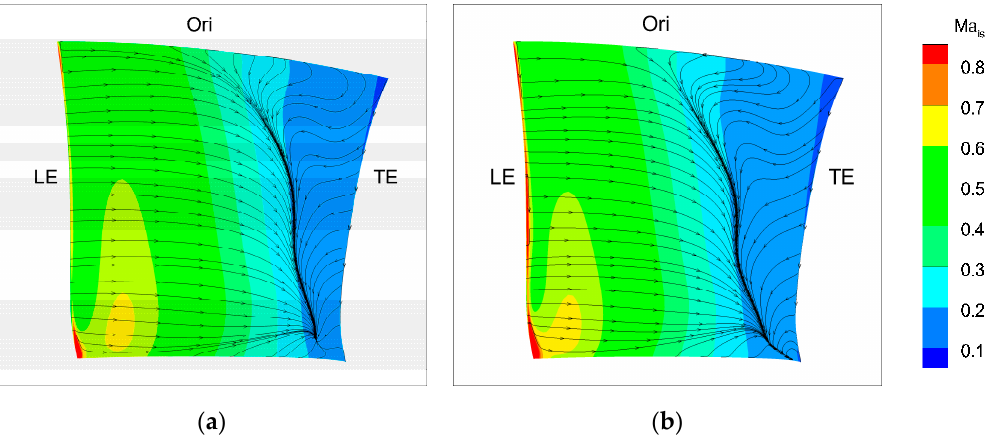
Figure 18. Limiting streamline on the suction surface of the second-stage stator from the peak efficiency condition to the near stall condition. ( a ) Limiting streamline on the suction surface at peak efficiency condition; ( b ) limiting streamline on the suction surface at near stall condition.